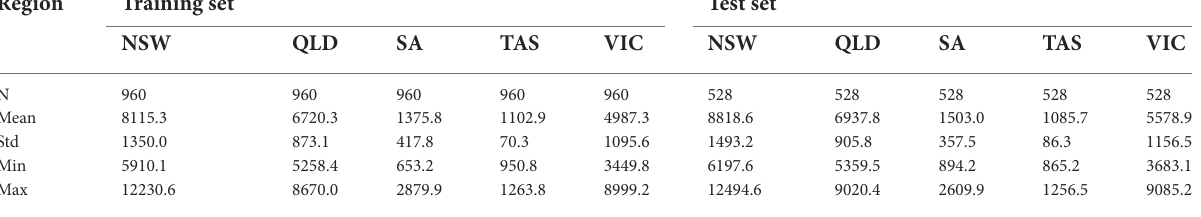
FIGURE 6 Datasets of all five regions.